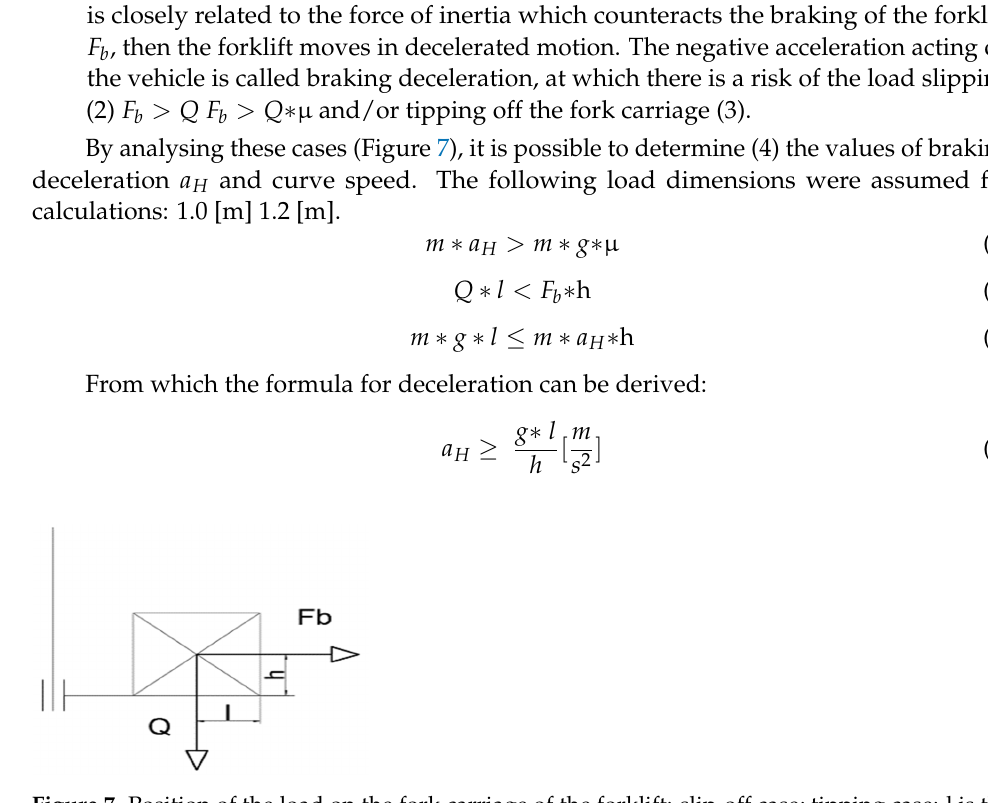
Figure 7. Position of the load on the fork carriage of the forklift: slip-off case; tipping case: l is the distance of the center of gravity of the load from the beginning of the fork; h is the height of the center of gravity of the load from the